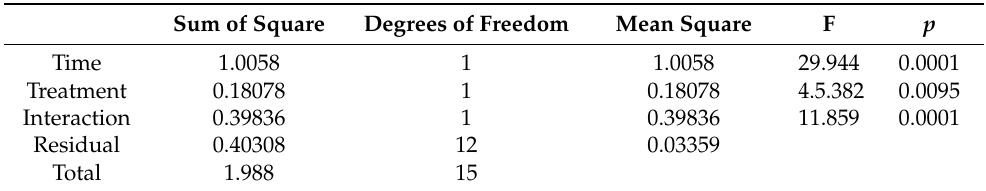
Table 1. Two-way Permanova based on the Jaccard distance of the microbial community profiles (indicated by the DGGE analysis) between 11 and 18 DAH.